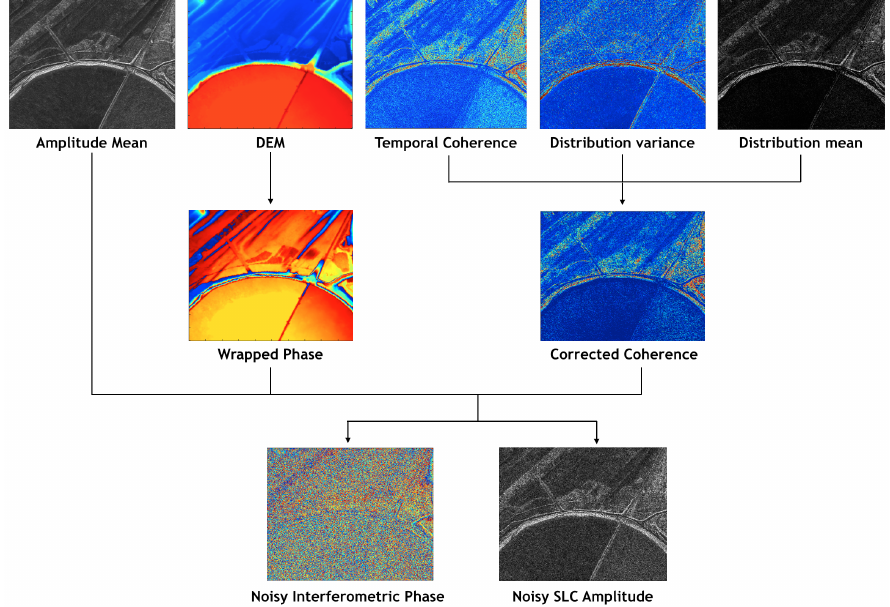
Figure 2. Schematic illustration of processing steps employed to simulate noisy interferogram and amplitude